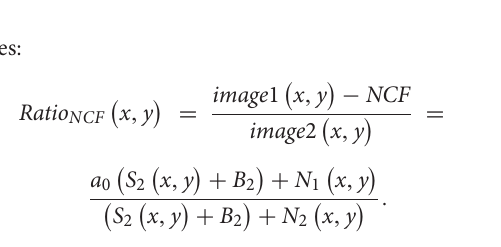
FIGURE 3 | Mean ratio signal as a function of the distance from the edge. Blue curves indicate the mean. Red dashed curves indicate the mean plus/minus one standard deviation. (A,B) The result for the left and right cells in Figure 1 based on the subtraction of the values halfway between the distant background value and the value used to define the cell mask. Here the deviations from the expected constant mean are 4.2 and 10.6%,